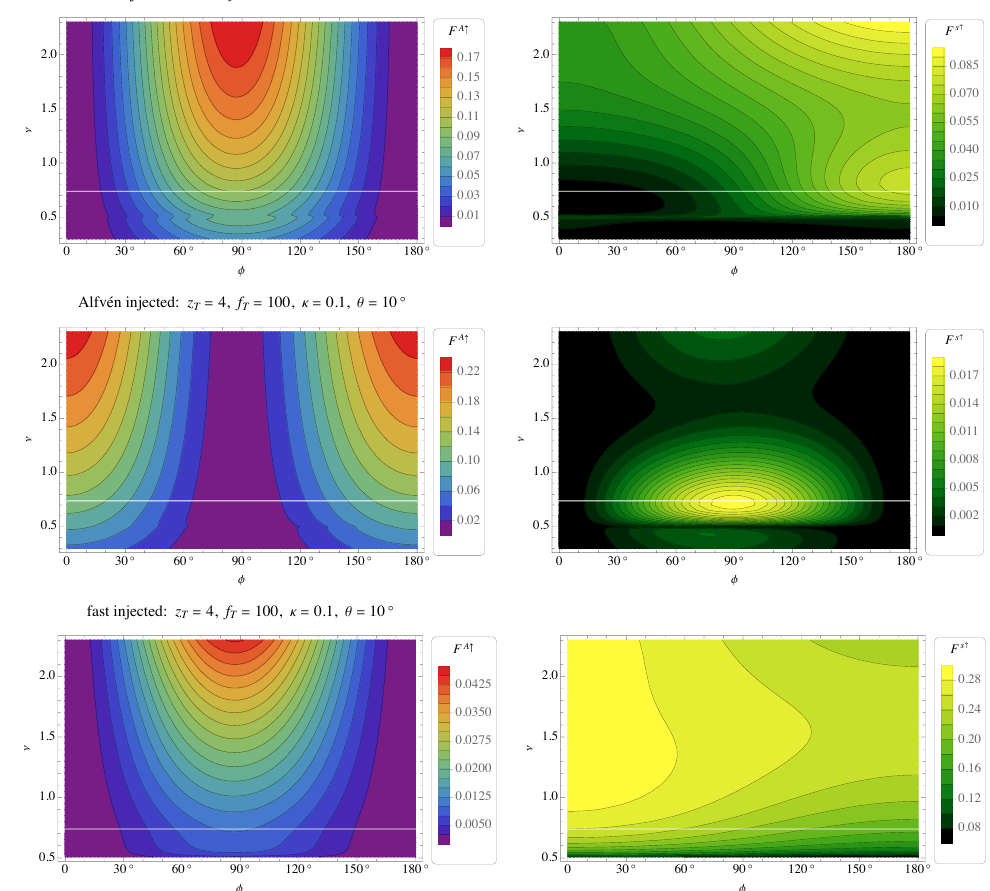
Figure 8. Same as Figure 5, but for z T = 4. The horizontal white line indicates the frequency above which the fast wave reaches the TR before reflecting.